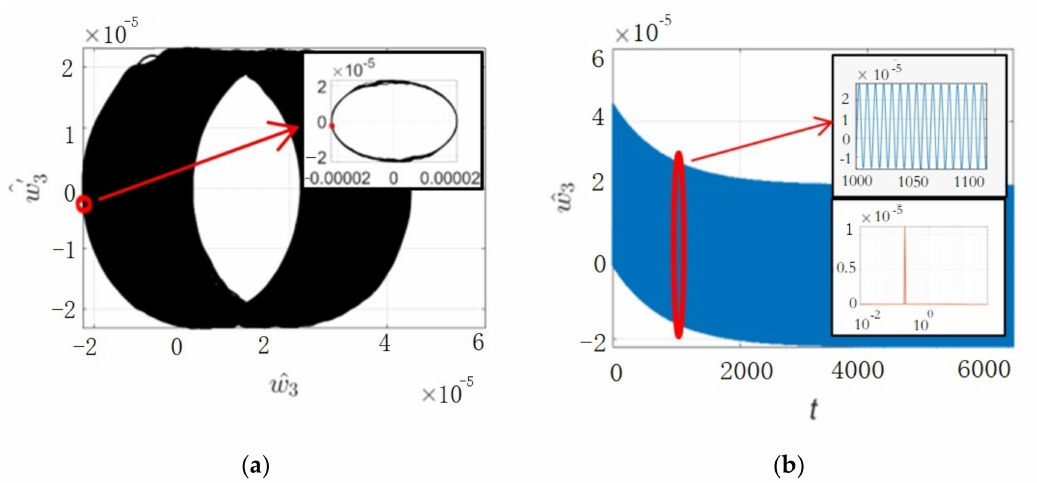
Figure 17. Periodical analysis of vertical rotation: ( a ) Poincar é phase diagram; ( b ) time history.